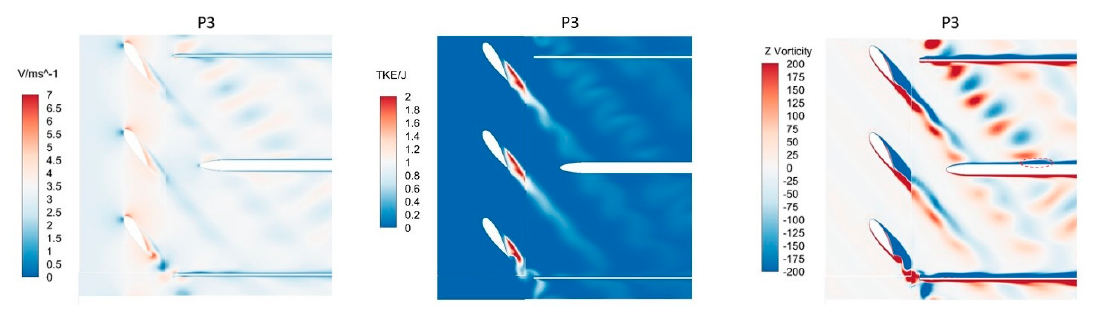
( b ) Contours at phase 2, left: velocity, middle: turbulence kinetic energy, right: z vorticity.